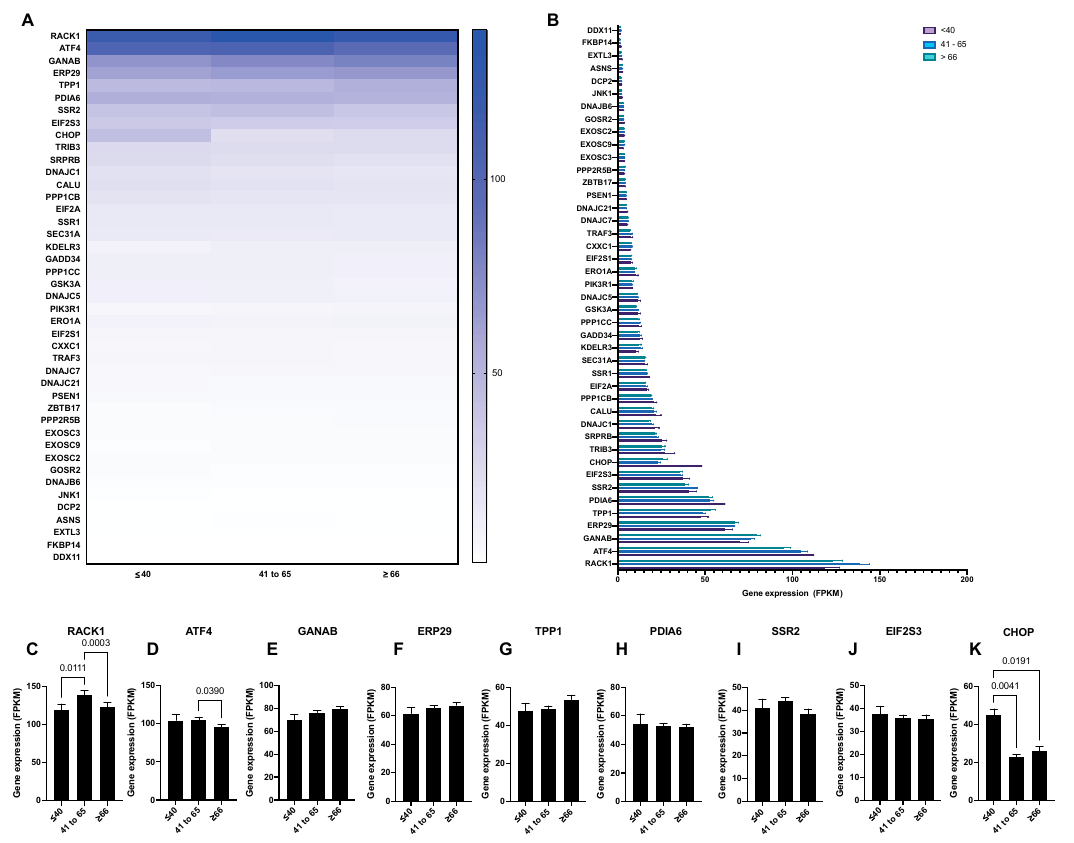
Figure 7. The mRNA expression of unfavorable UPR-associated markers per age group shown in a heatmap ( A ) and a bar chart ( B ). The selected markers are shown as individual bar charts ( C – K ).